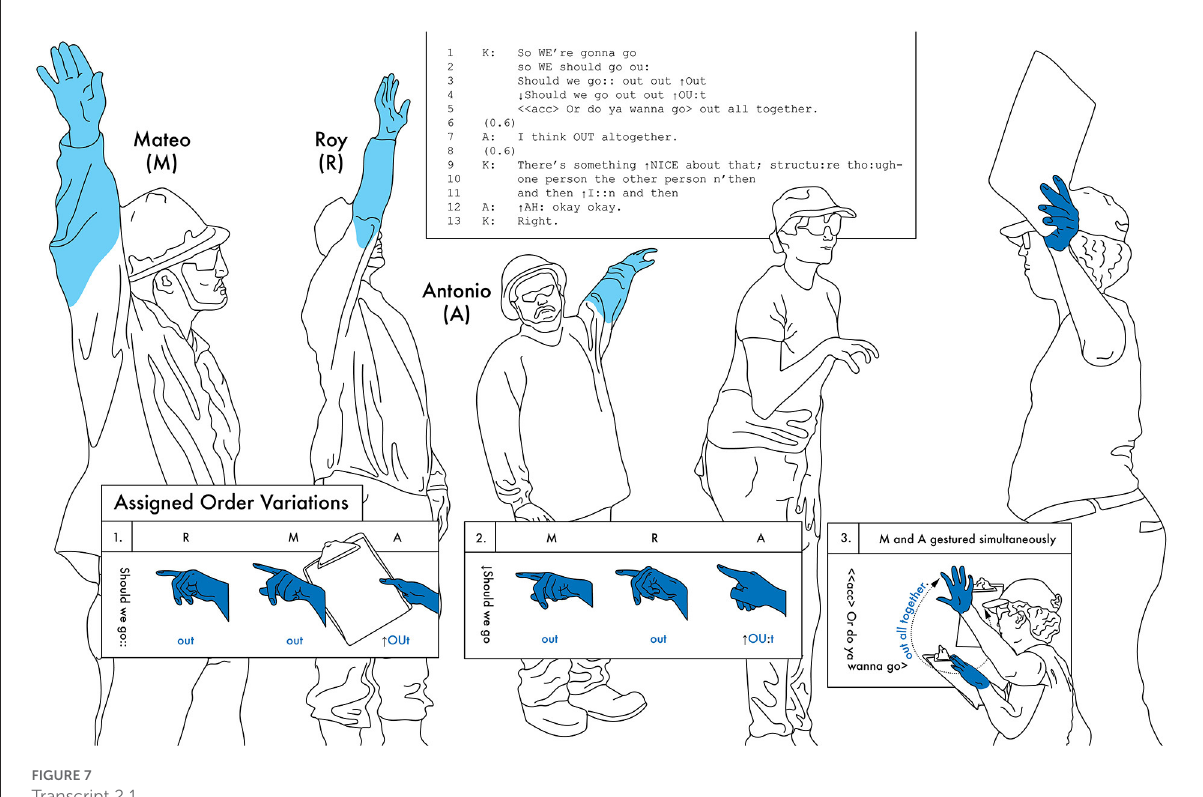
FIGURE7 Transcript